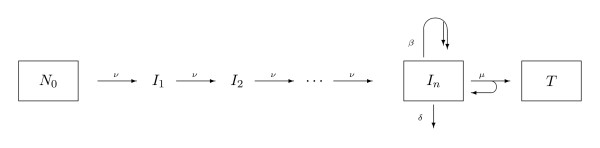
The multistage carcinogenesis model. N0 denotes the number of normal stem cells. To get initiated, a normal cell accumulates n consecutive mutations, where ν denotes the mutation rate per cell per year for the gene in question. The number of cells having k mutations is noted Ik, 1 ≤ k ≤ n. The fully initiated cells, In, expand according to a birth-and-death process. These cells give rise to tumor cells T if a further event happens, and μ/(μ + β) can be interpreted as the probability of such a malignant transformation during a cell division.